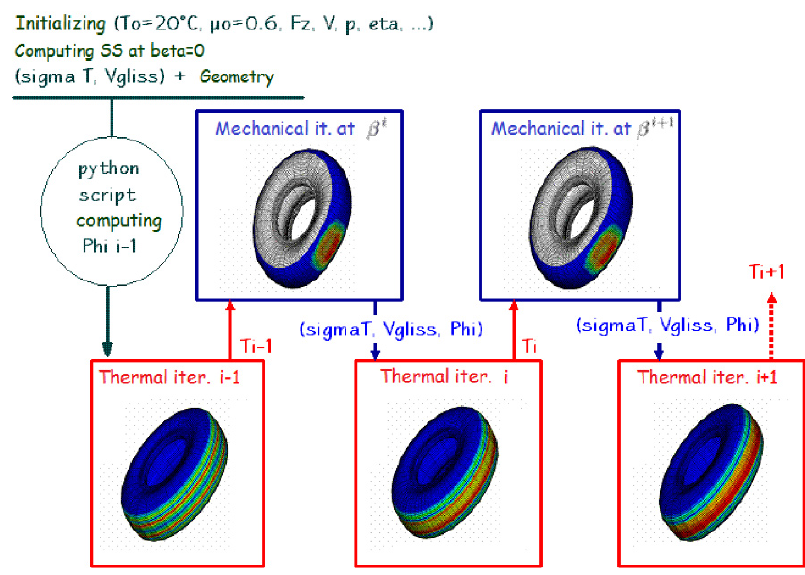
Figure 16. Thermomechanical coupling process on an aircraft tire without any